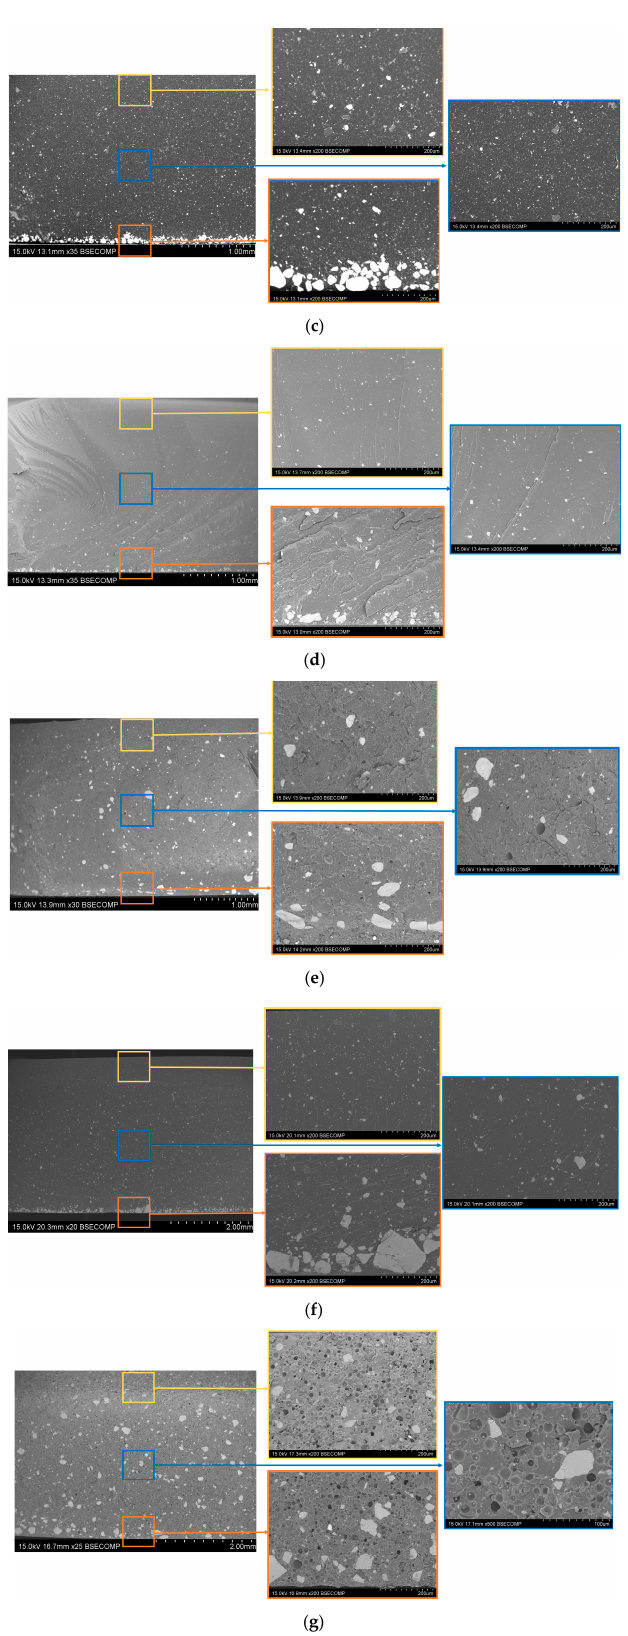
Figure 3. SEM images of the fracture surfaces of the ( a ) 8MNP, ( b ) 10 MNP, ( c ) 12MNP, ( d ) 14MNP, ( e ) 14MNP-15MS, ( f ) 20MNP and ( g ) 20MNP-15MS